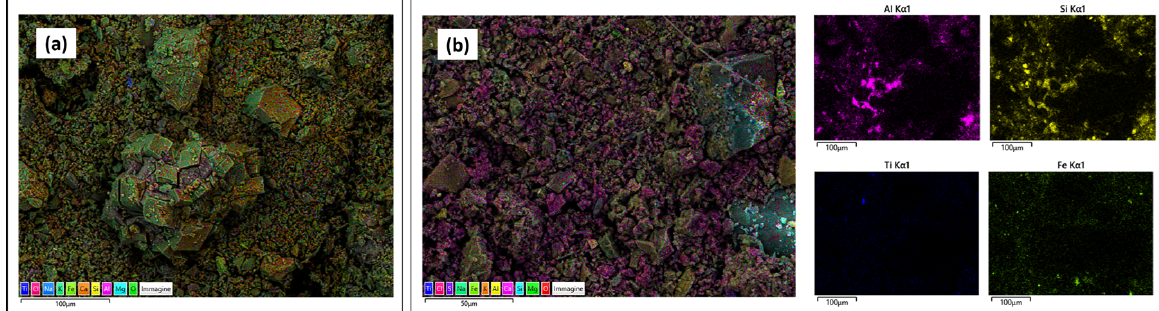
Figure 15. ( a ) Sample P4 SEM-EDX composite image; ( b ) another part of sample P4.